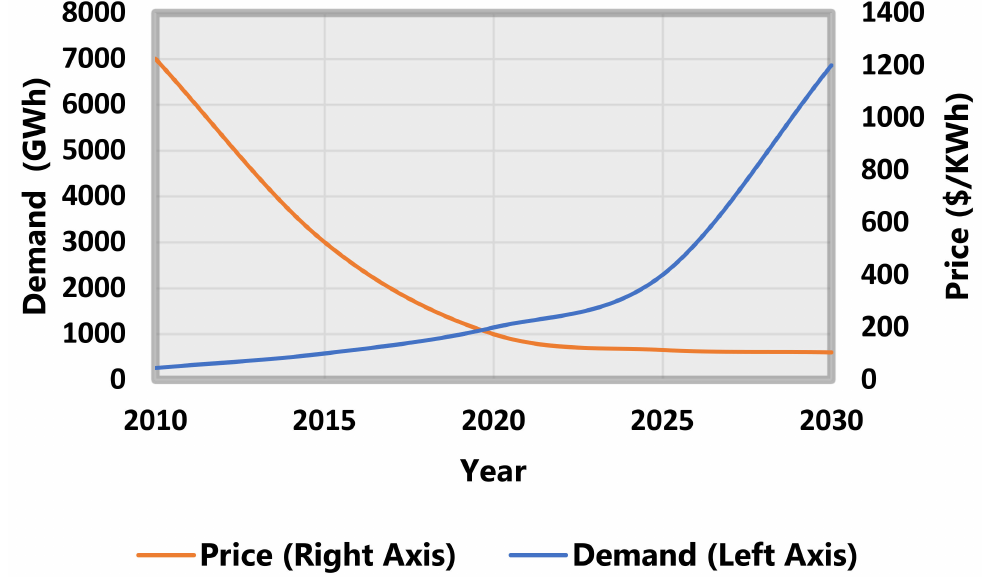
Figure 1. The demand-led market growth of Li-ion batteries (data derived from